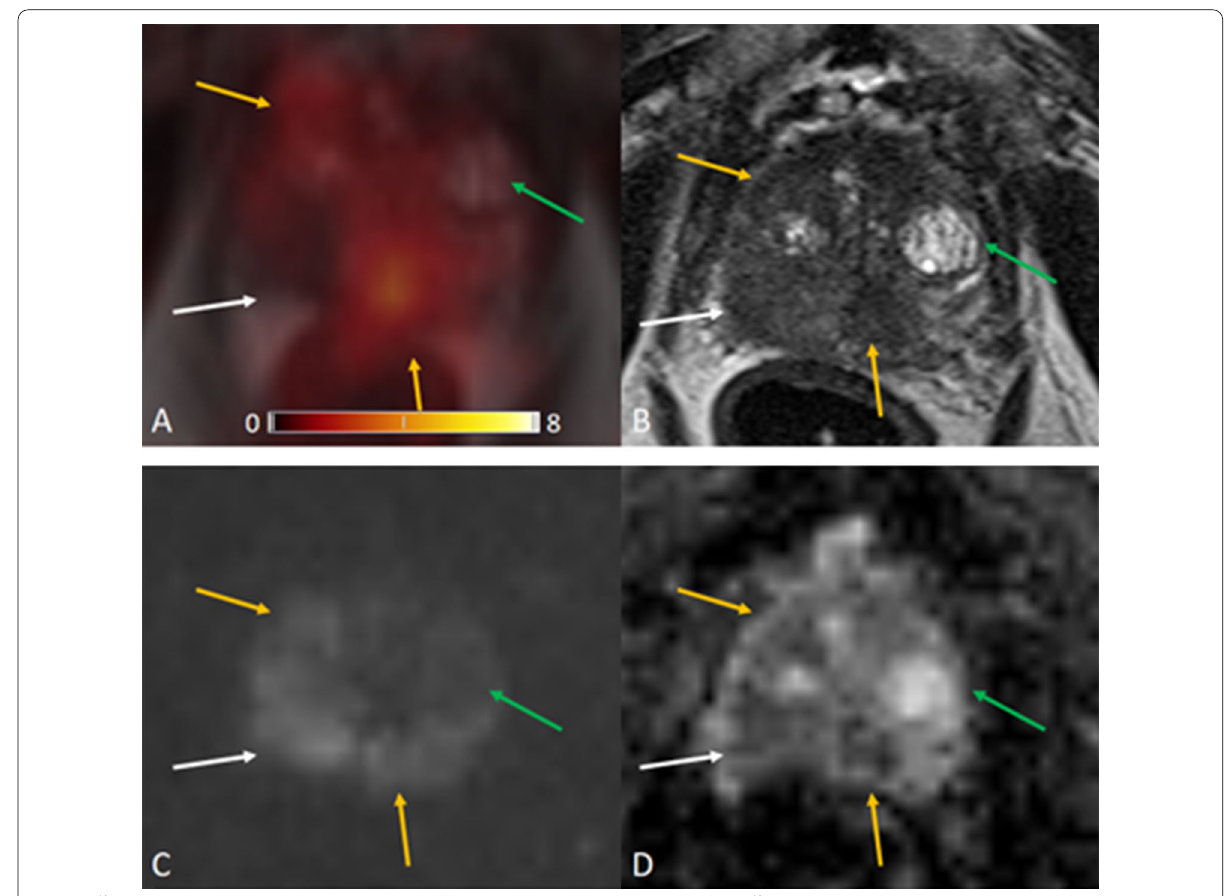
Fig. 4 [ 68 Ga]Ga-PSMA PET/MRI images obtained in a 79-year-old man, PSA 2.20 ng/mL. a [ 68 Ga]Ga-PSMA PET/MRI; b T2WI; c DWI, b value 1000 s/ mm 2 ; d ADC. Background SUVmax 1.7. MRI-positive lesions are yellow arrows and white arrow. Yellow arrow: SUVmax 5.9, LBR 3.5 (middle of PZ) and 4.2, LBR 2.5 (right TZ). White arrow: SUVmax 1.6, LBR 0.9 (right PZ). MRI-negative lesion is green arrow, SUVmax 1.4, LBR 0.8 (left TZ). This example showed that MRI-positive lesions could be either PSMA avid uptake (yellow arrows) or unapparent PSMA uptake (white arrows). And MRI-negative lesions could be unapparent PSMA uptake (green